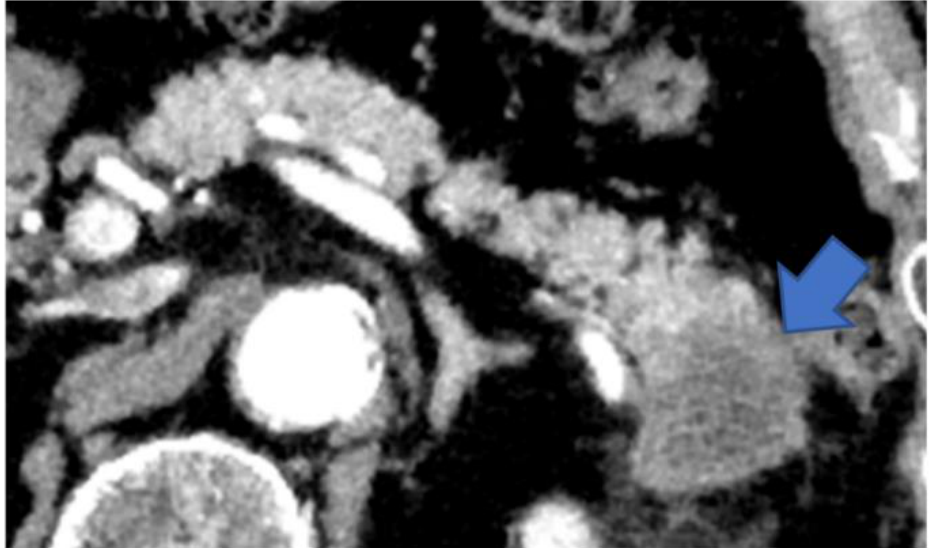
Type V: Cases that form a mass located on the caudal side of the pancreas (Figure 8).